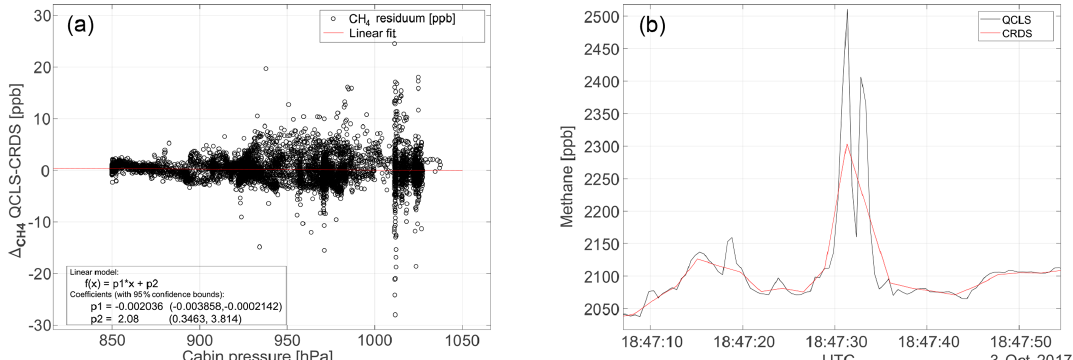
Figure 12. Panel (a) shows the cabin pressure dependence for a typical flight on 3 October 2017. The large cabin pressure dependence in excess of 0.3ppbhPa − 1 reported by Pitt et al. (2016) has effectively been minimized using the calibration strategy from Sect. 2.3. Panel (b) shows a temporal zoom on the CH 4 mole fractions at 18:47UTC to emphasize the benefit of high-frequency measurements.